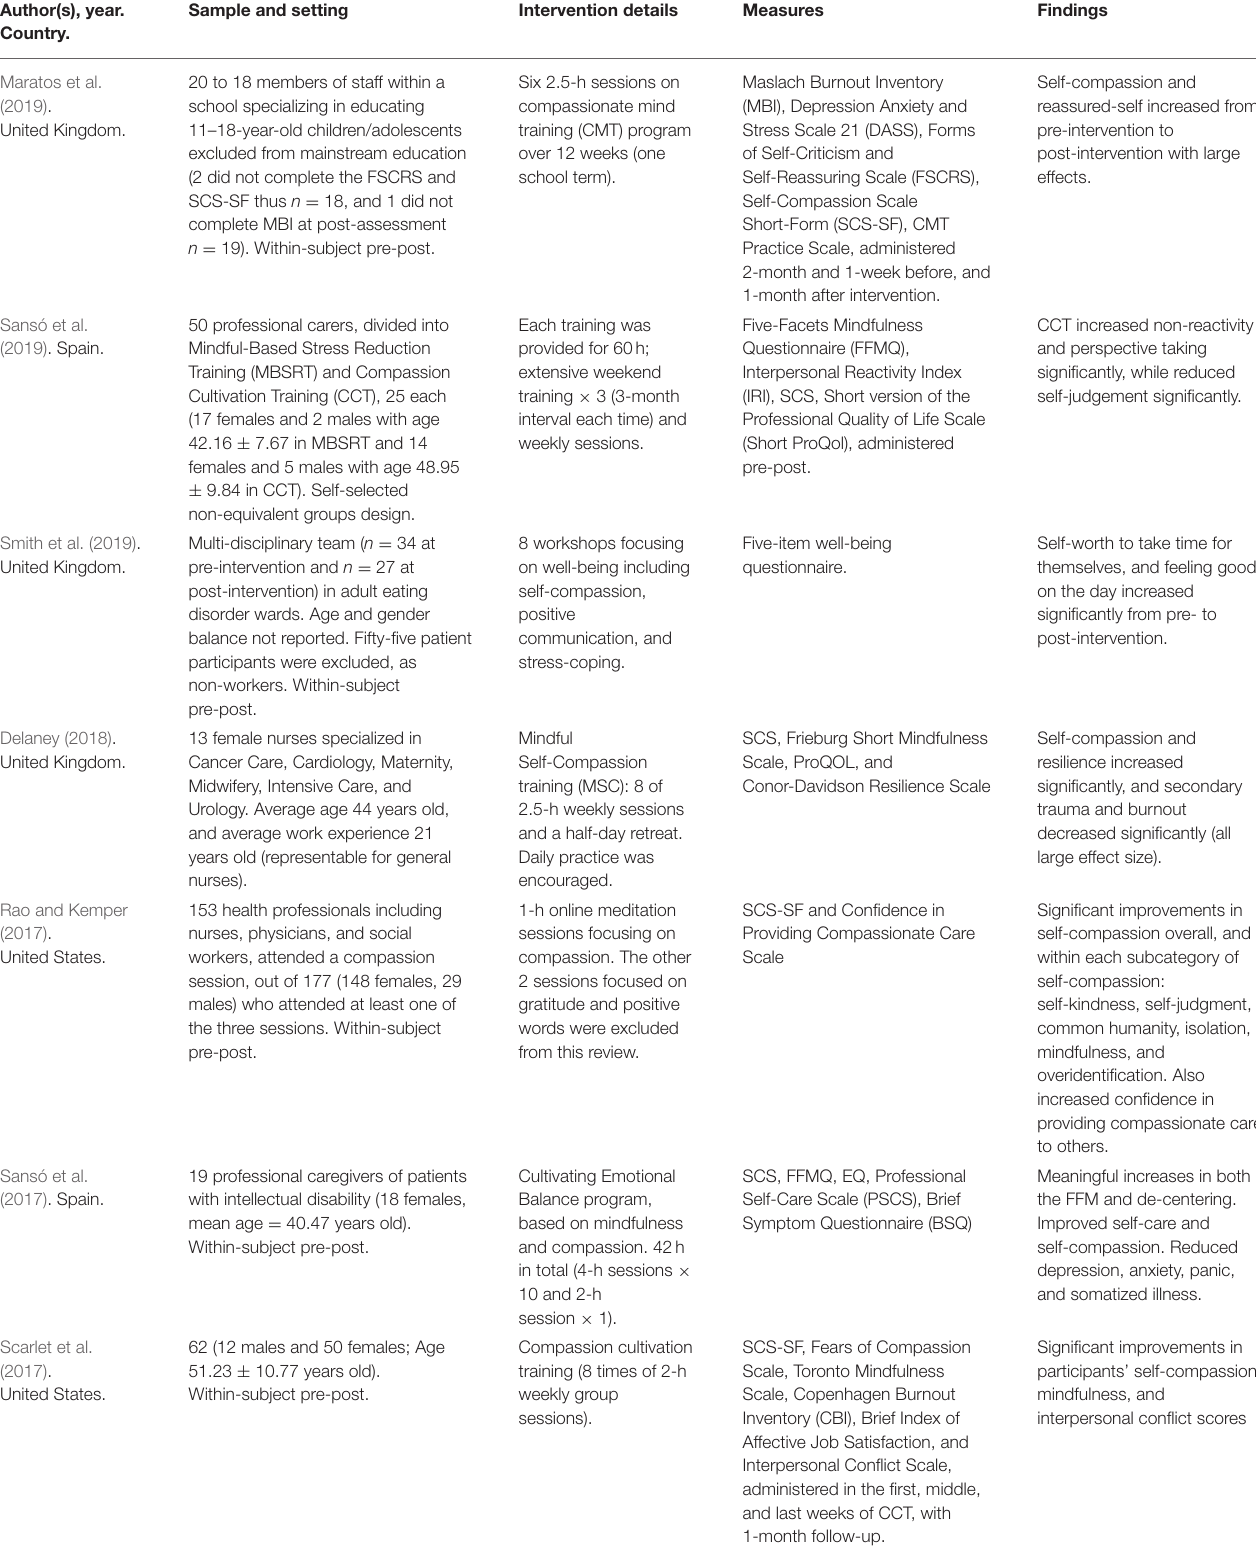
TABLE 2 | Study details of selected papers exploring the effects of self-compassion training on work-related well-being outcomes. Author(s), year.